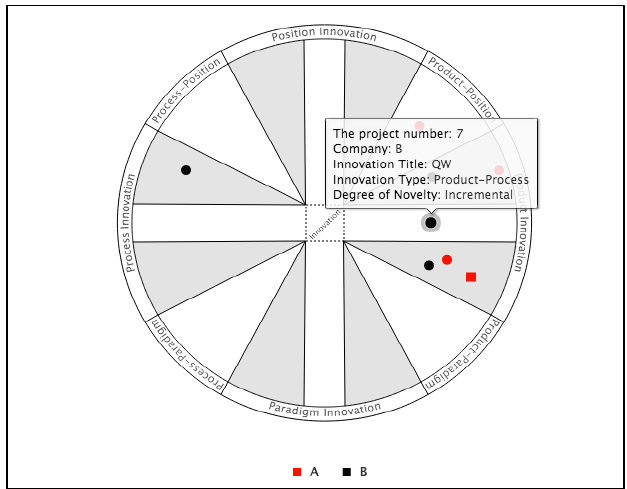
Fig. 11. Illustration of the Details Given for Each Innovation on the Chart